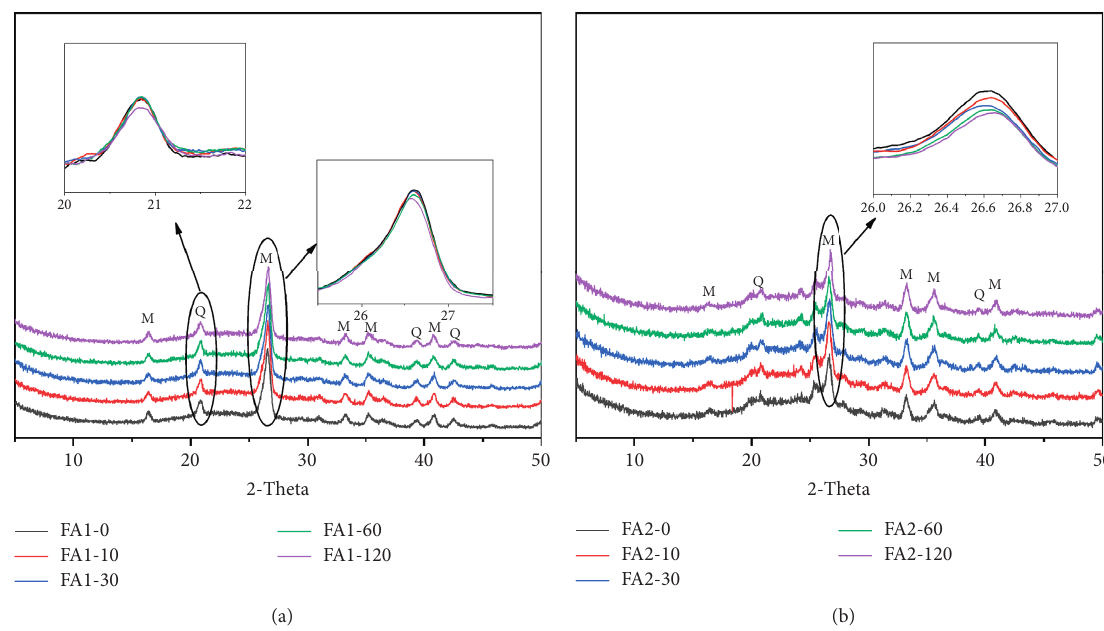
Figure 4: Phase assembles of FA: (a) FA1 and (b) FA2 (M: mullite; Q: